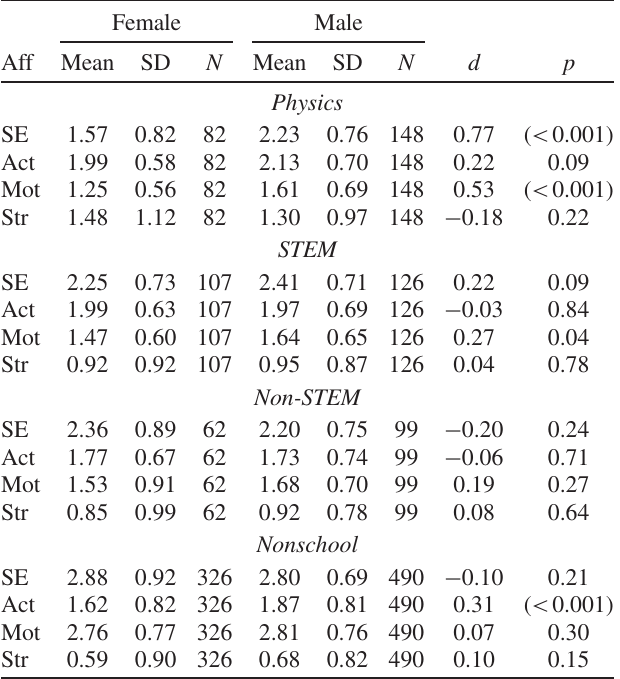
TABLE IV. Gender differences in raw experience across activities and affective constructs. Abbreviations in the first column are affective construct (Aff), self-efficacy (SE), activation (Act), intrinsic motivation (Mot) and stress (Str).